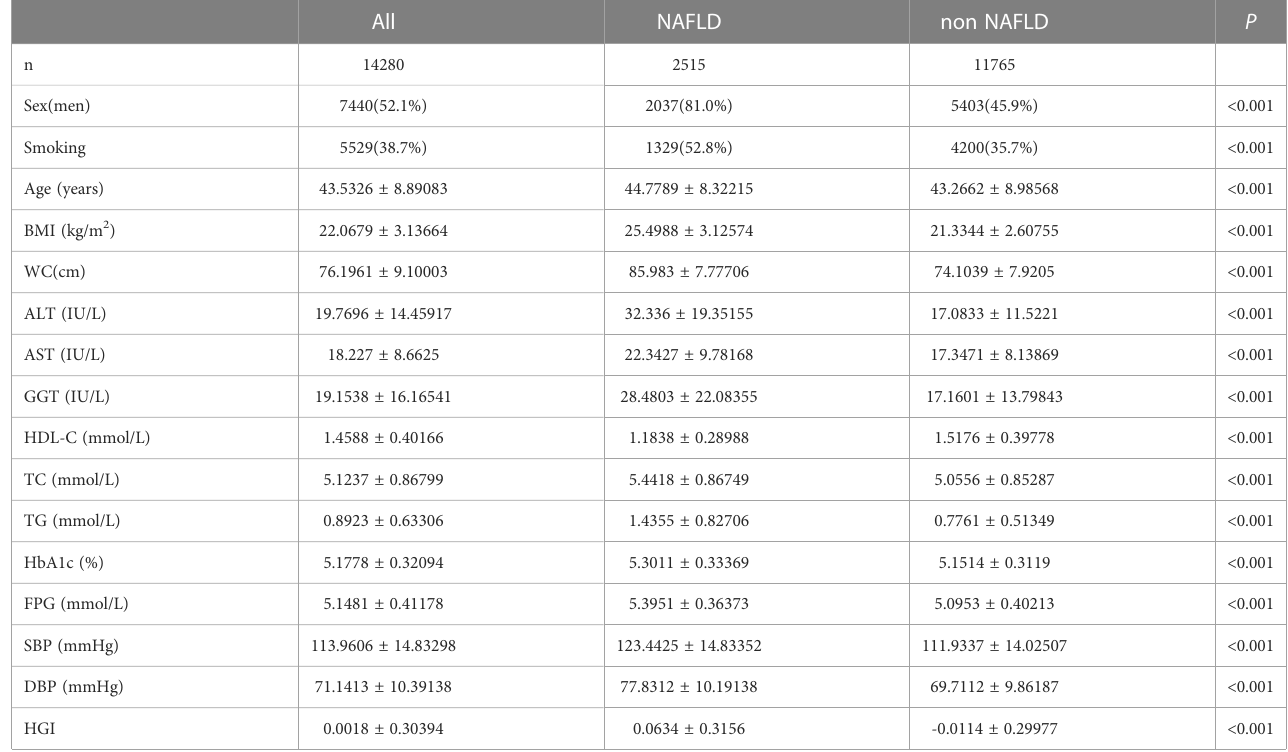
TABLE 1 Comparison of clinical indicators between the NAFLD and no NAFLD groups. All NAFLD non